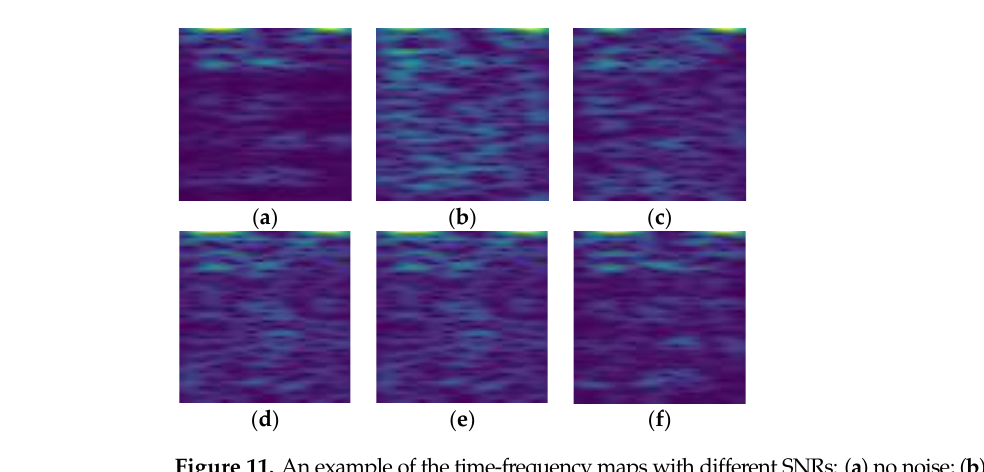
Figure 11. An example of the time-frequency maps with different SNRs: ( a ) no noise; ( b ) the SNR of − 2 dB; ( c ) the SNR of 0 dB; ( d ) the SNR of 2 dB; ( e ) the SNR of 4 dB; ( f ) the SNR of 6 dB. Table 8. Accuracy of the proposed model MCDS-CNN, and other five models on data set A with different SNR.